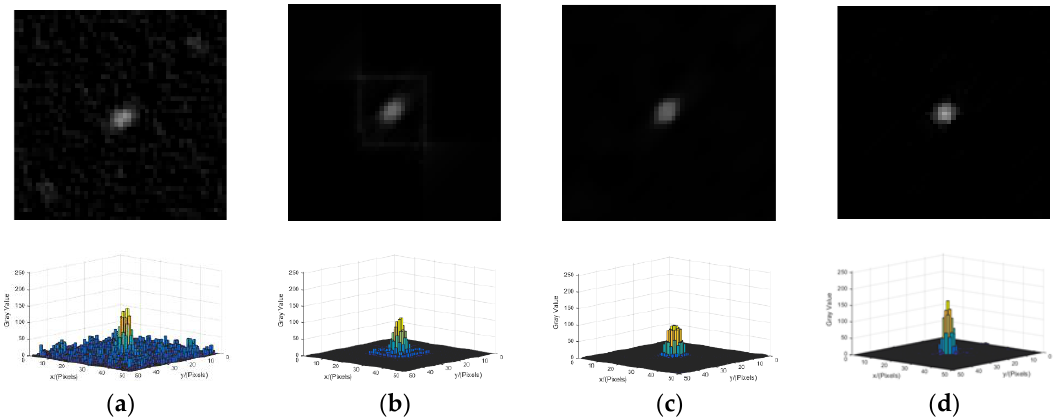
Figure 16. Reconstruction results of different methods. ( a ) Reconstruction result of the Wiener filter. ( b ) Reconstruction result of the accelerated Richardson – Lucy (RL) method. ( c ) Reconstruction result ( b ) Reconstruction result of the accelerated Richardson–Lucy (RL) method. ( c ) Reconstruction result of of p -regularization. ( d ) Reconstruction result of the proposed method. (cid:96) p -regularization. ( d ) Reconstruction result of the proposed method.